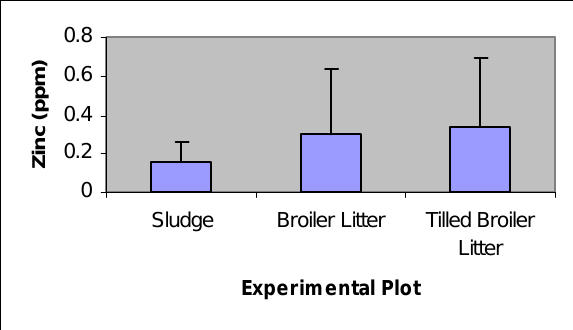
Figure 4 : Mean zinc levels (ppm) detected in the various experimental